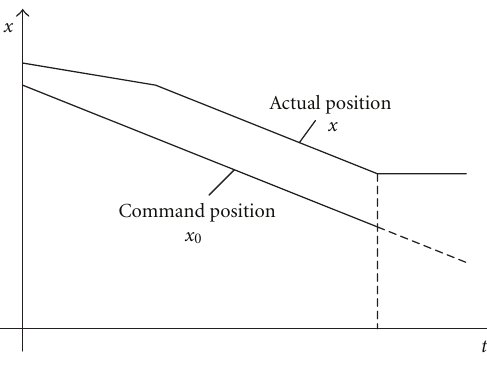
Figure 6: Illustration of the measurement of workpiece.